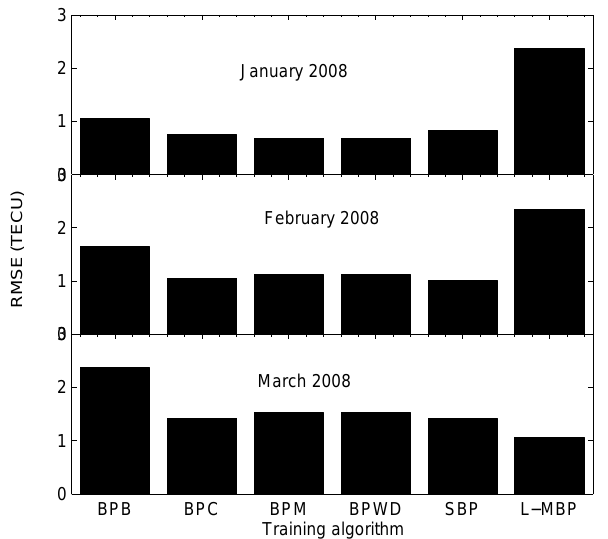
Fig. 7. RMSE values for January, February and March 2008.